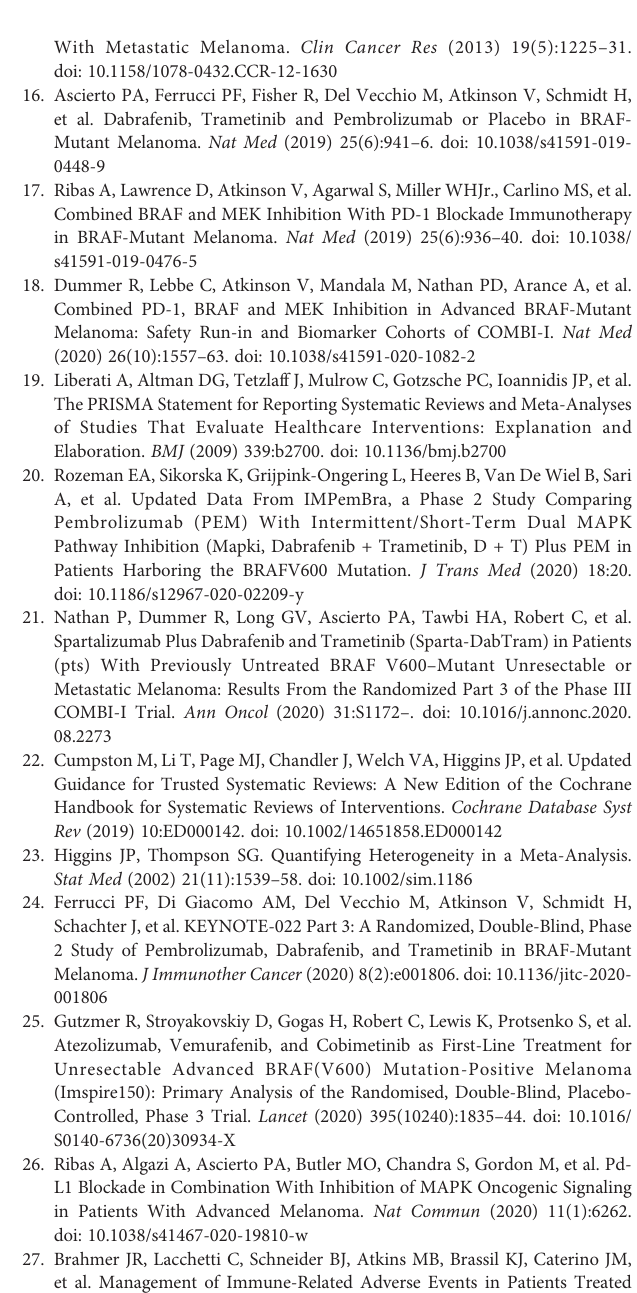
Supplementary Figure 1 | Sensitivity analysis of progression free survival (PFS).